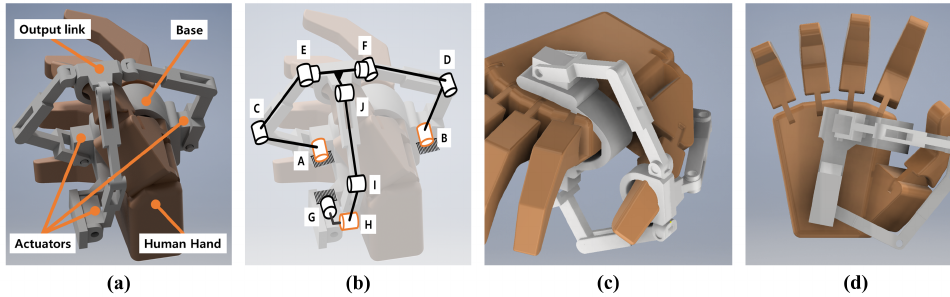
Figure 3. Conceptual design of proposed mechanism for the thumb rehabilitation: ( a ) 3D view, ( b ) overlapped with joint diagram, ( c ) Top view, ( d ) Bottom view (adapted by